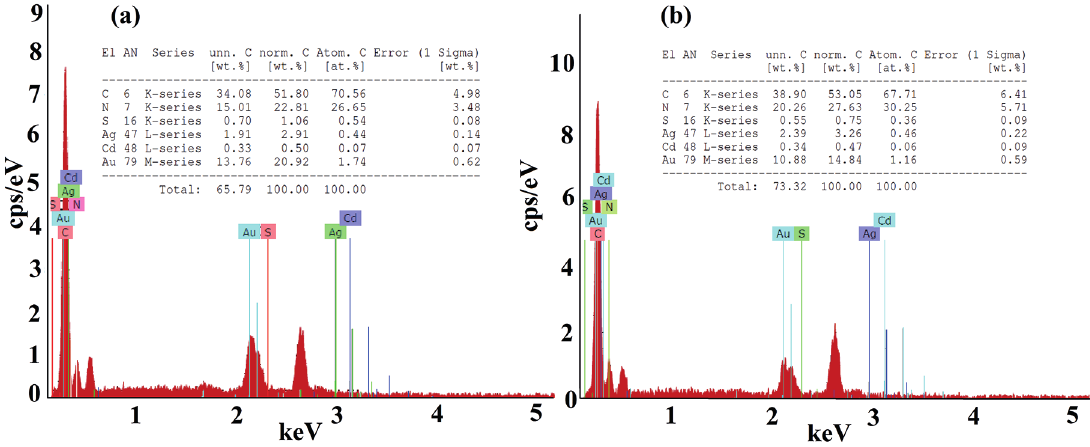
S:CdS hybrid of nanoparticles. 2